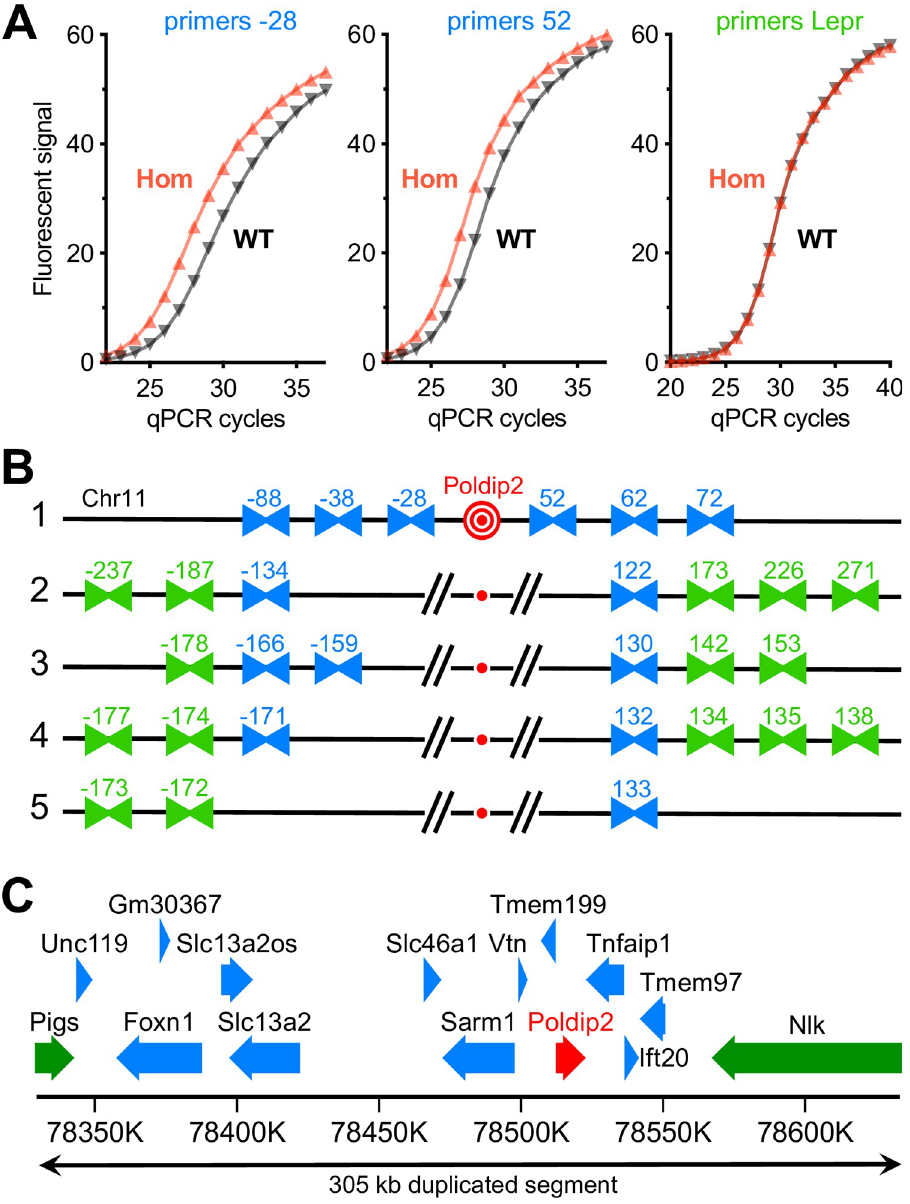
Fig 4. Mapping the genomic duplication in initial floxed Poldip2 mice. Two samples of genomic DNA were selected to map the duplication: one wild-type (WT) and one homozygous (Hom) floxed Poldip2 , identified by copy number variation assays as in Fig 3A. Multiple primer pairs, annealing to chromosome 11 (Chr11) on either side of the Poldip2 gene, were designed. A: Validation of the qPCR method with SYBR green detection. The Hom sample amplified earlier than the WT with primer pairs annealing either 28 kb upstream (-28) or 52 kb downstream (52) of exon 4 in Poldip2 , as expected for duplicated DNA. In contrast, both samples amplified at the same cycle number with a primer pair annealing within the leptin receptor (Lepr) on chromosome 4. Each amplification curve represents the average fluorescent intensity from 4–6 replicates. B: Mapping was carried out in five successive rounds of primer design and testing. In this schematic (not to scale), primer pairs are represented by facing arrowheads labeled according to the approximate distance in kb between their annealing site and floxed Poldip2 (in red at the center). Blue and green colors indicate primer pairs found to anneal inside and outside the duplication, respectively. In the first two rounds of screening, primer pairs were designed to anneal progressively further away from Poldip2 on Chr11. After finding primers annealing outside the duplication, the last three rounds progressively identified primers closer to the edges of the duplication. In the end, these results indicate that the length of the duplicated segment is between 304 kb (133+171) and 306 kb (134+172). C: Genomic map of duplicated DNA segment in floxed Poldip2 mice. The largest protein coding genes and their orientations are represented as thick arrows. Gene information and nucleotide numbering